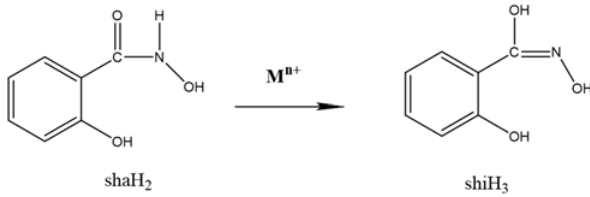
Scheme 1. Illustrative representation and abbreviation of organic molecules discussed in the text.